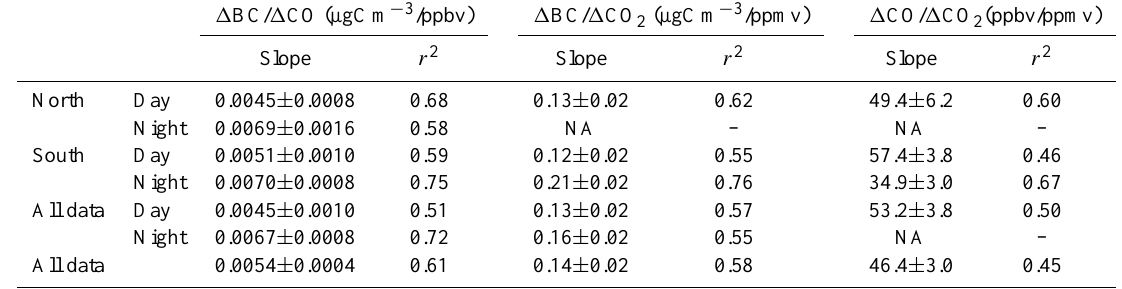
Table 4. Observed BC-CO, BC-CO 2 , and CO-CO 2 linear regressions slopes ( ± 2 σ , within 95.4% confidence interval).